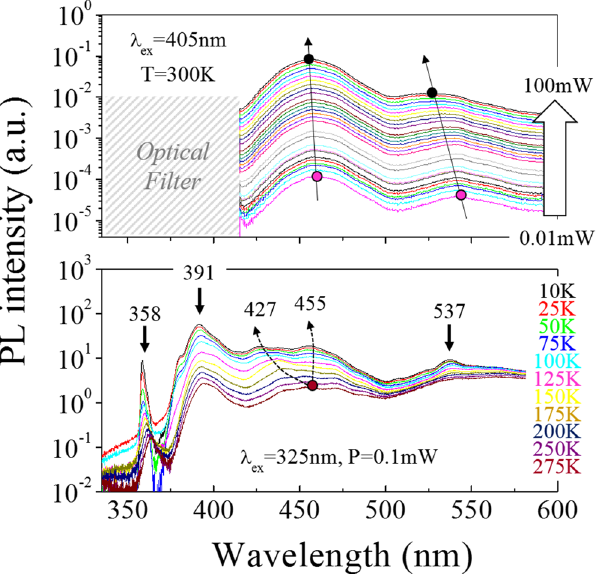
Figure 3. Power (top) and temperature (bottom) dependent PL of the NR based LED structure. The green contribution displays a strong QCSE at high excitation power, while the blue emission splits in two contributions at low